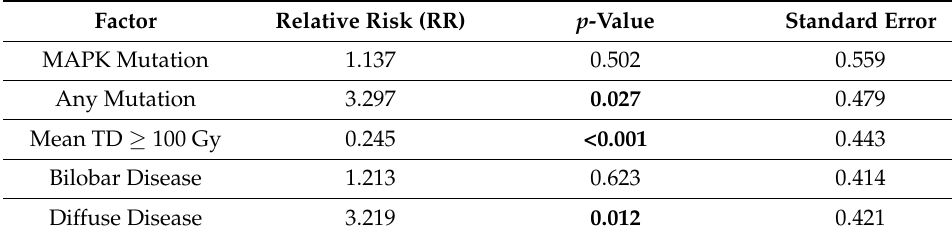
Table 4. Multivariate Analysis of Prognostic Factors.